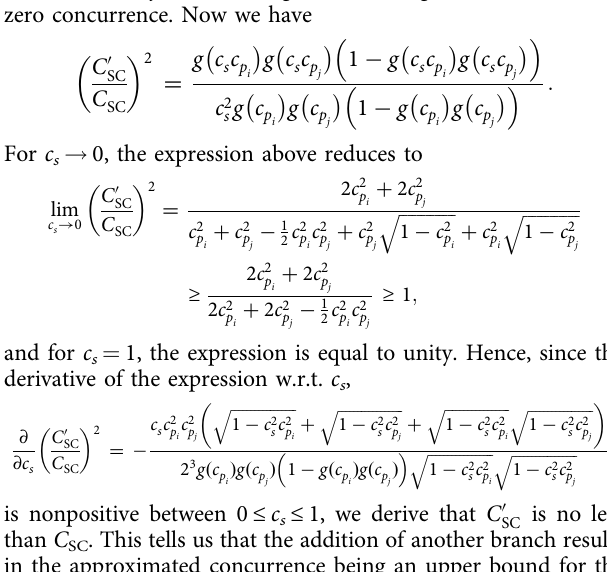
ffiffiffiffiffiffiffiffiffiffiffiffiffiffiffiffiffi q þ 1 (cid:2) c 2 s c 2 p i